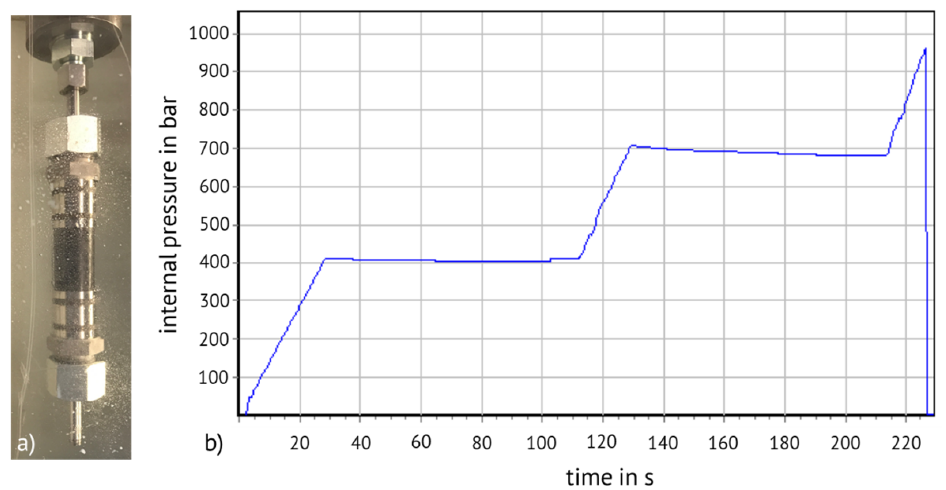
Figure 14. Pressure test of ultrasonically welded hybrid Ti6Al4V-fitting/CF-PEEK-tube joint: ( a ) CF-PEEK-tube with ultrasonically welded Ti6Al4V-fitting on both ends and ( b ) pressure-time-profile, pictures provided by courtesy of Parker Hannifin GmbH Bielefeld.